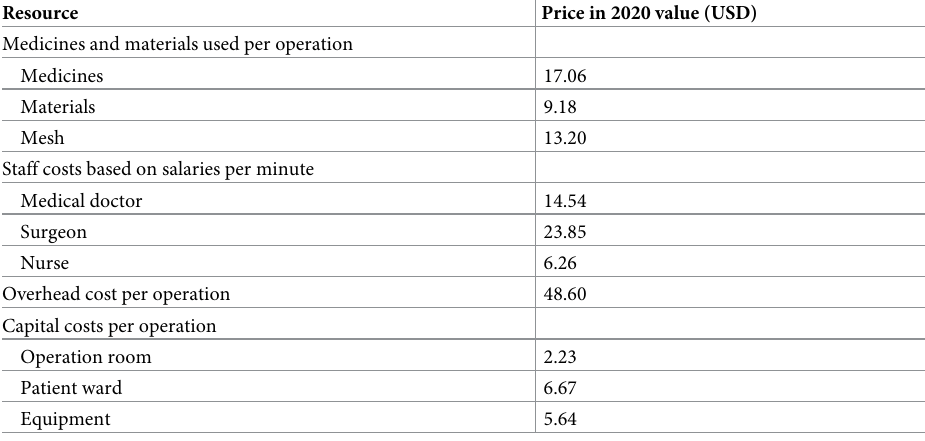
Table 2. Resource use and prices included in the